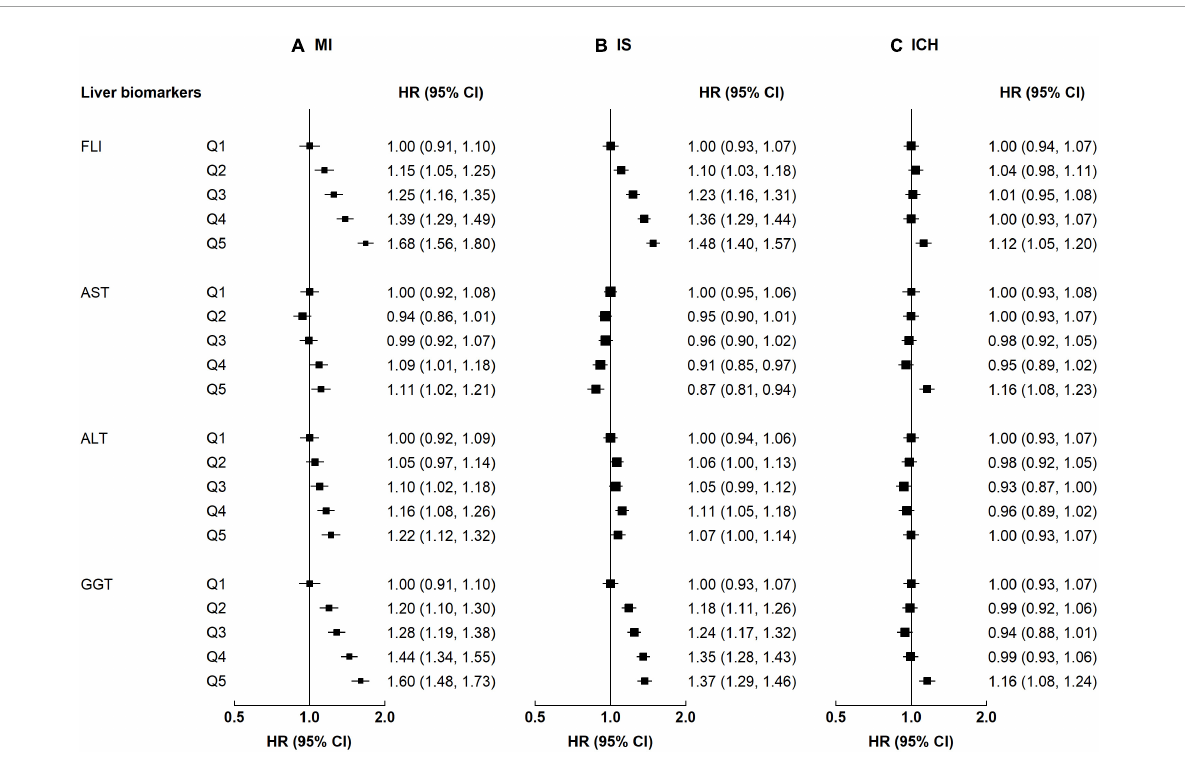
observed for MI or IS. Compared with those with 0 risk alleles, the HRs for ICH were 1.06 (1.01–1.10) and 1.11 (1.03–1.20) among participants with 1 allele and 2 alleles,